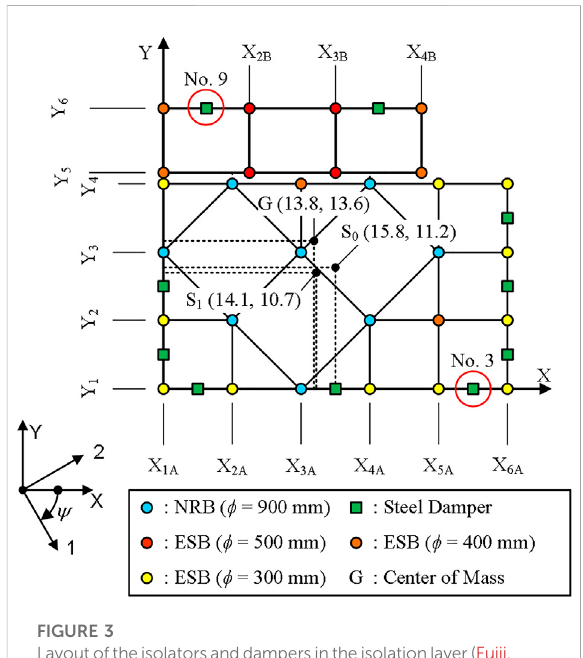
FIGURE 3 Layoutoftheisolatorsanddampersintheisolationlayer(Fujii, 2021).